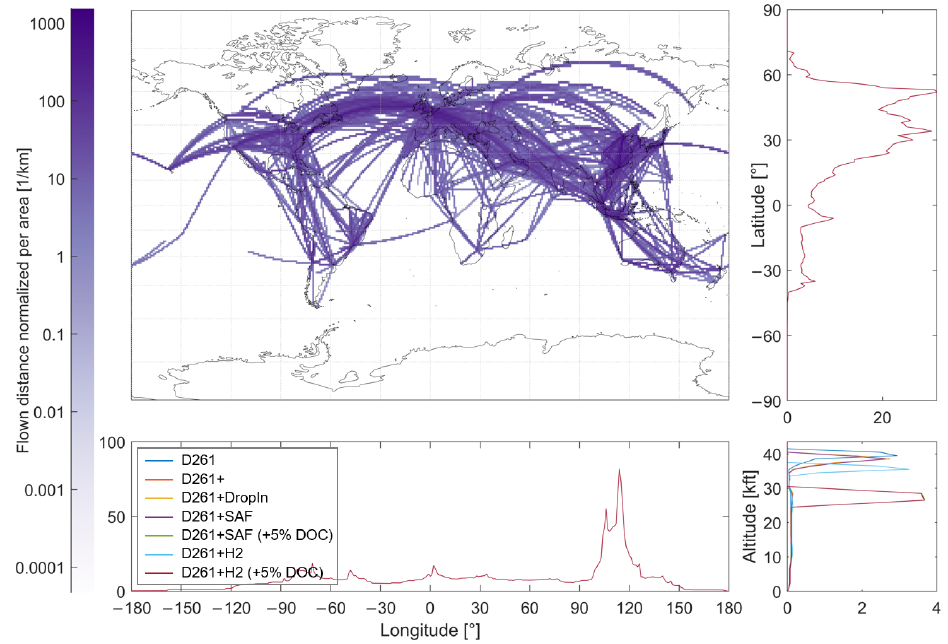
Figure 6. Global distribution of flown distances covered by the underlying route